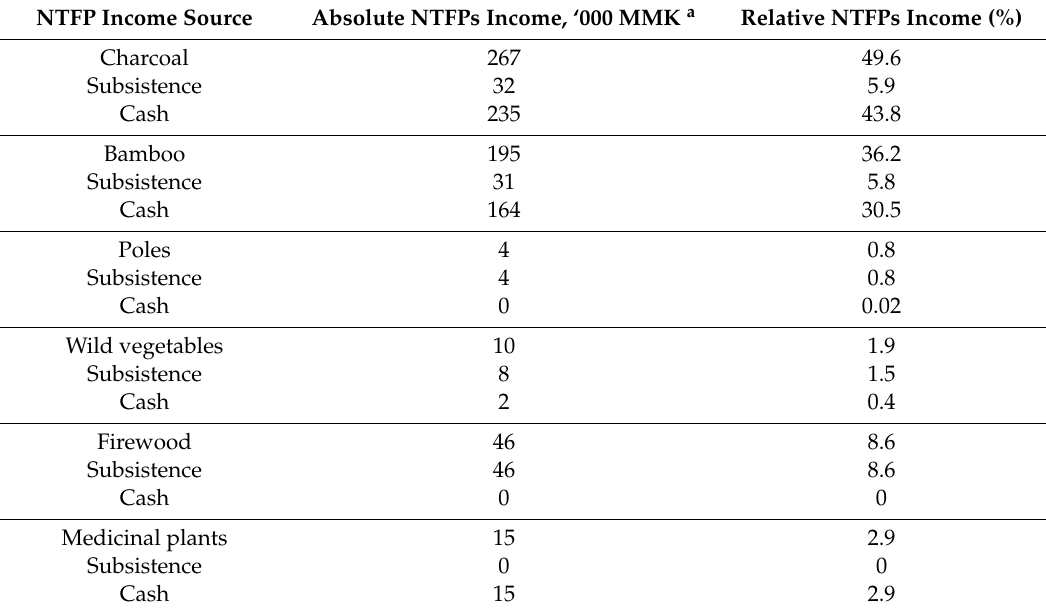
Table 4. Household annual income from NTFPs, absolute and relative (%), Taungoo District,